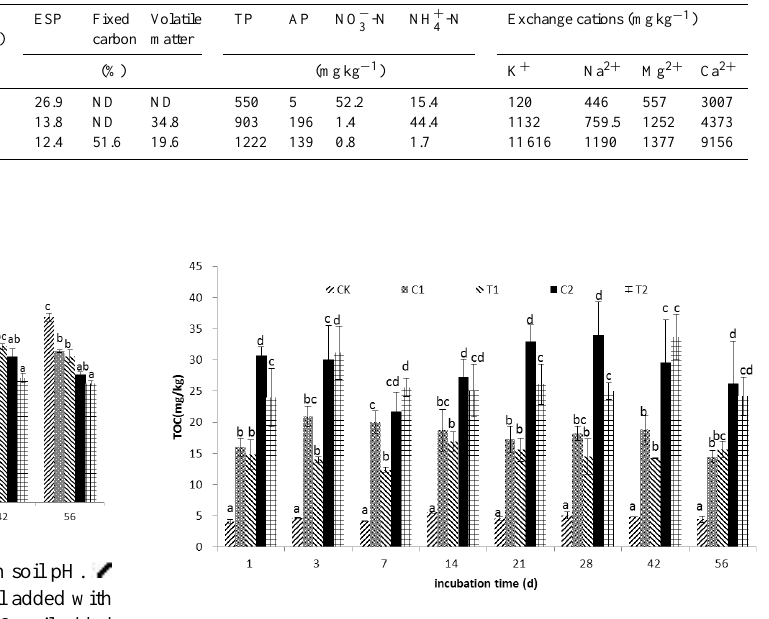
Table 1. The physical and chemical properties of materials in this study.